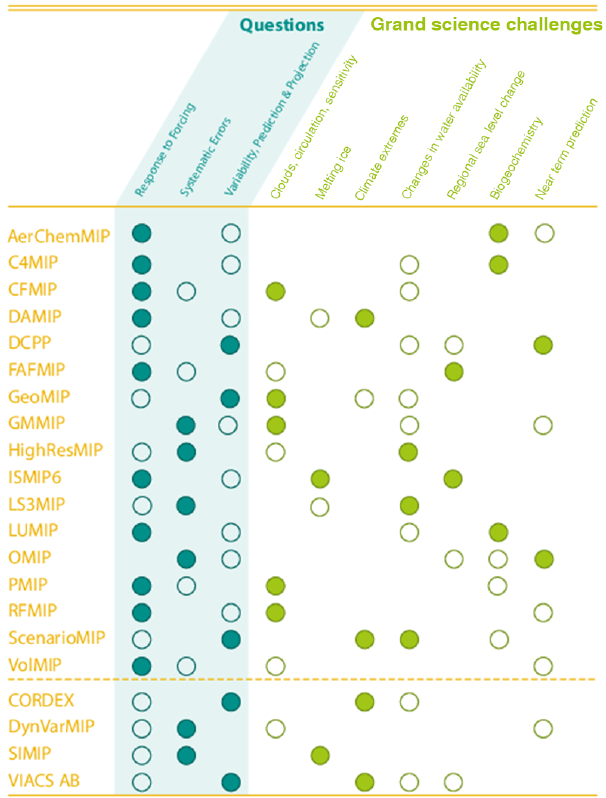
Figure 3. Contributions of CMIP6-Endorsed MIPs to the three CMIP6 science questions and the WCRP Grand Science Chal- lenges. A filled circle indicates highest priority and an open circle, second highest priority. Some of the MIPs additionally contribute with lower priority to other CMIP6 science questions or WCRP Grand Science